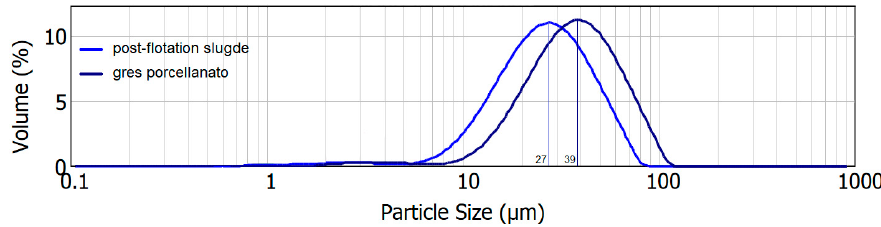
Figure 3. Grain distributions of sludge and gres porcelanato NG raw